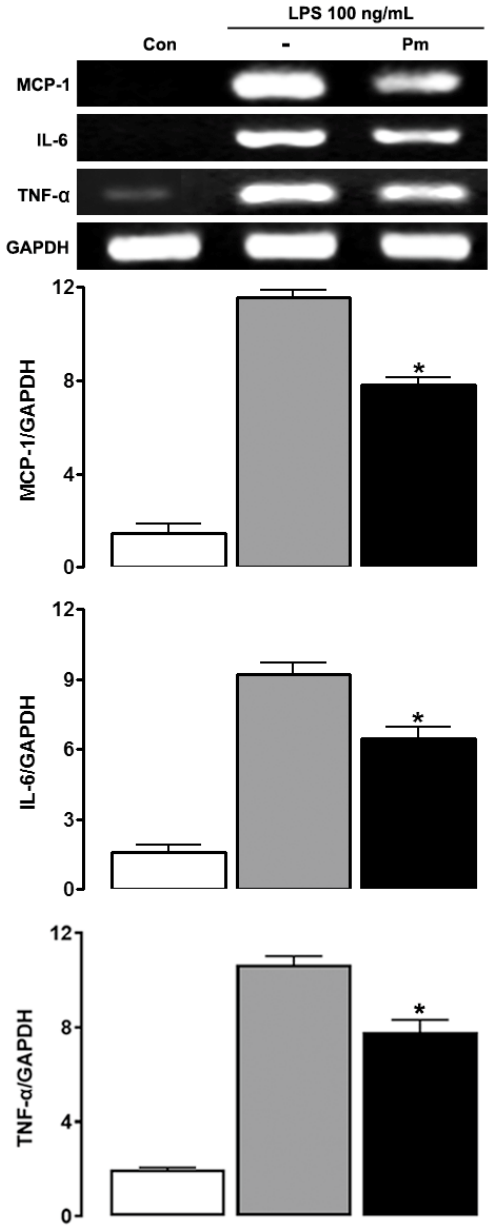
Figure 5. Effects of P. mirifica extract on LPS-induced MCP-1, IL-6, and TNF- α mRNA expression. HAPI cells (5 × 10 5 cells/well) were pretreated for 1 h with 100 ng/mL P. mirifica extract before being stimulated with 100 ng/mL LPS for 6 h. Total RNA was harvested and subjected to semiquantitative RT-PCR. GAPDH was used as a reference for equal loading. The relative expression levels of MCP-1, IL-6, and TNF- α transcript were normalized with respect to GAPDH. The results are representative of three independent experiments. * p < 0.05 compared with the LPS-treated group.